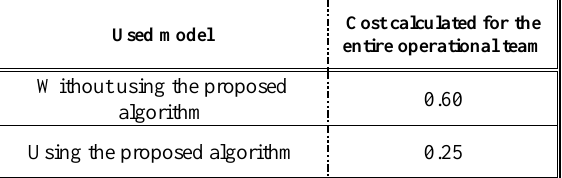
Table 1: Comparison of the results of the proposed algorithm and its